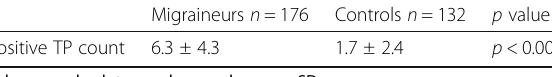
Table 1 Comparison between the positive tender point (TP) count in migraineurs and those of controls Migraineurs n = 176 Values are absolute numbers and mean±SD u Mann-Whitney U